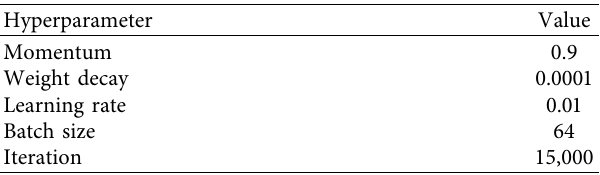
Table 2: Training hyperparameters.